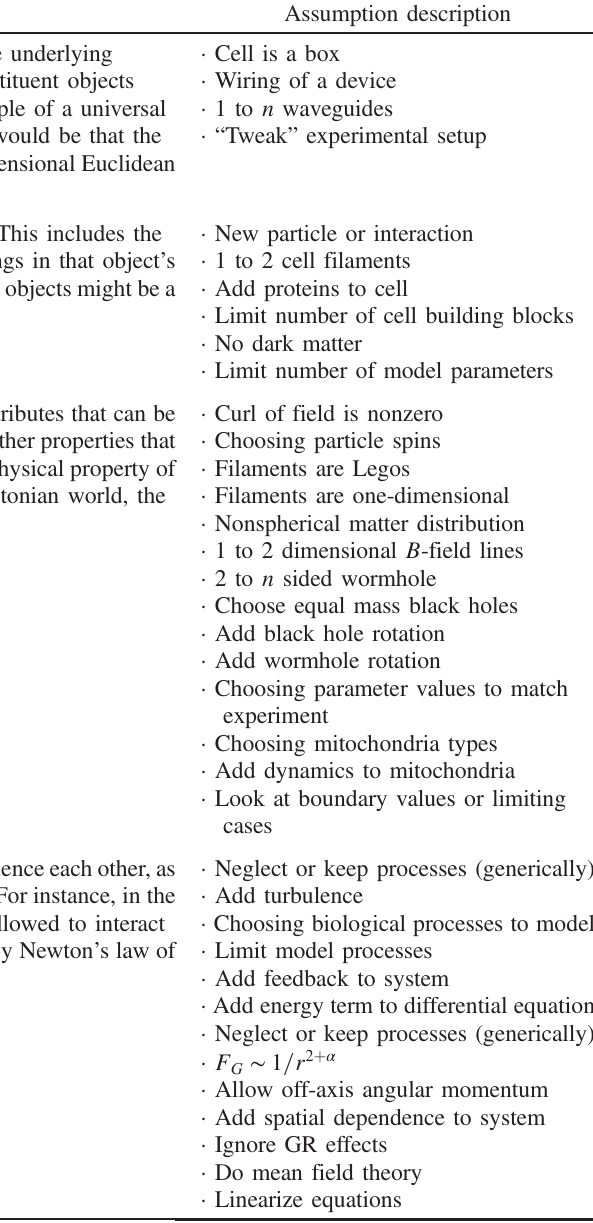
TABLE IV. Examples of the diverse assumptions that theorists described, organized according to a variation of Hestenes ’ [47] description of conceptual models described in Sec. II. Inclusion Assumption